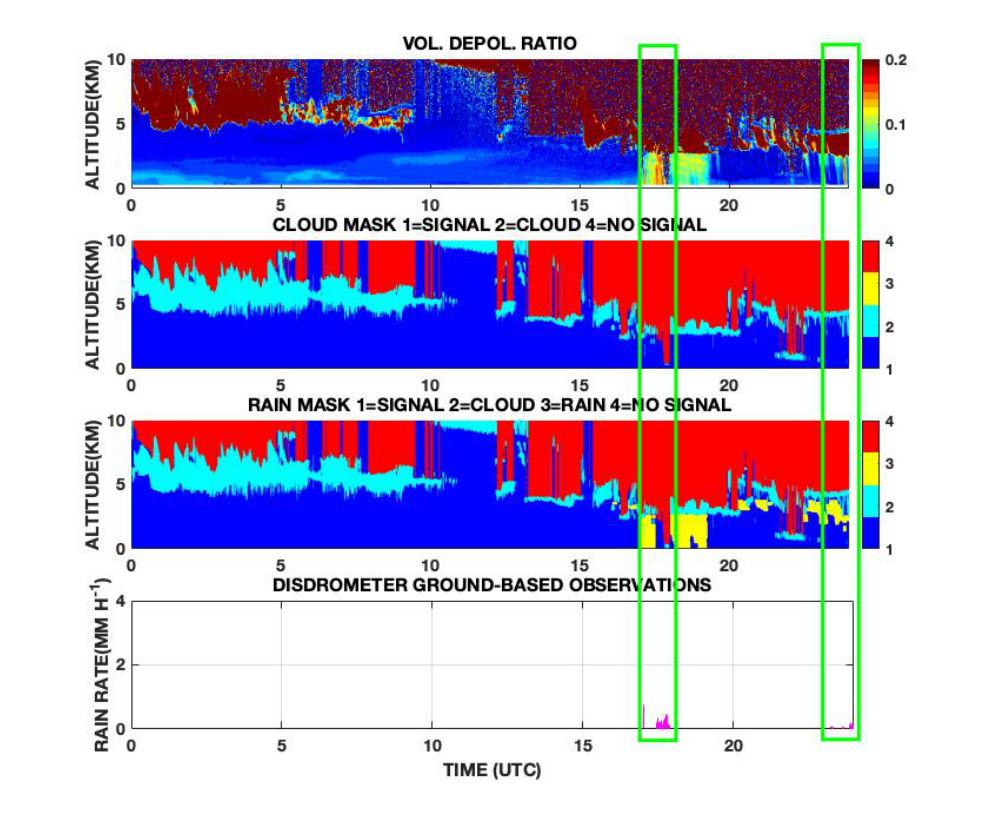
Figure 5. Rain mask variable from rain detection algorithm on 22 April 2016 from MPLNET observation at NASA GSFC (Lat: 38.99 N, Lon: 76.38 W, Alt: 50 m a.s.l.). The different steps to obtain the rain mask are shown in the flowchart in Figure 3: Upper : Volume depolarization ratio variable obtained from MPLNET NRB L15 signal product. Middle 1 : Cloud mask variable from MPLNET L15 CLD product. The algorithm retrieves precipitation only on blue regions topped by clouds (cyan bins). Middle 2 : New rain mask product (rain plotted in yellow). Lower : Co-located precipitation intensity measured by disdrometer. The green rectangular shapes help in visualizing the detected rain